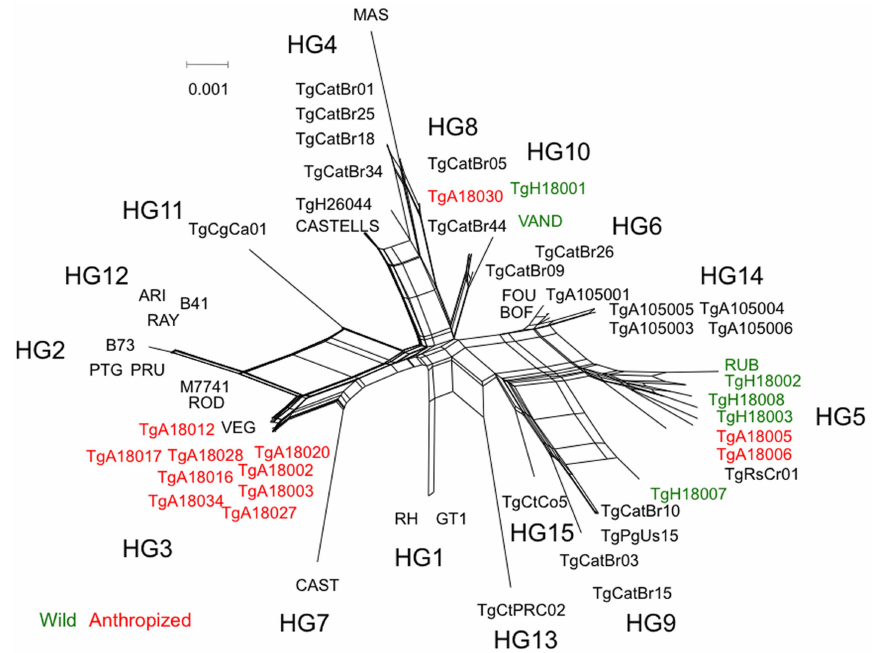
Figure 3. Analysis of T.gondii strains based on intron markers. Strains isolated from anthropized environment vs. wild Neotropical rainforest of French Guiana were compared to type strains representing the major haplogroups (HG designations). Neighbor-net analysis was conducted using four intron sequences ( UPRT 1, UPRT 7, EF 1, and HP 2). Rainforest isolates clustered with two previously defined haplogroups 5 and 10, whereas anthropized isolates clustered with haplogroup 3. Color-coding indicates the region of origin: anthropized environment (red), wild Neotropical rainforest (green), and HG reference strains (black).